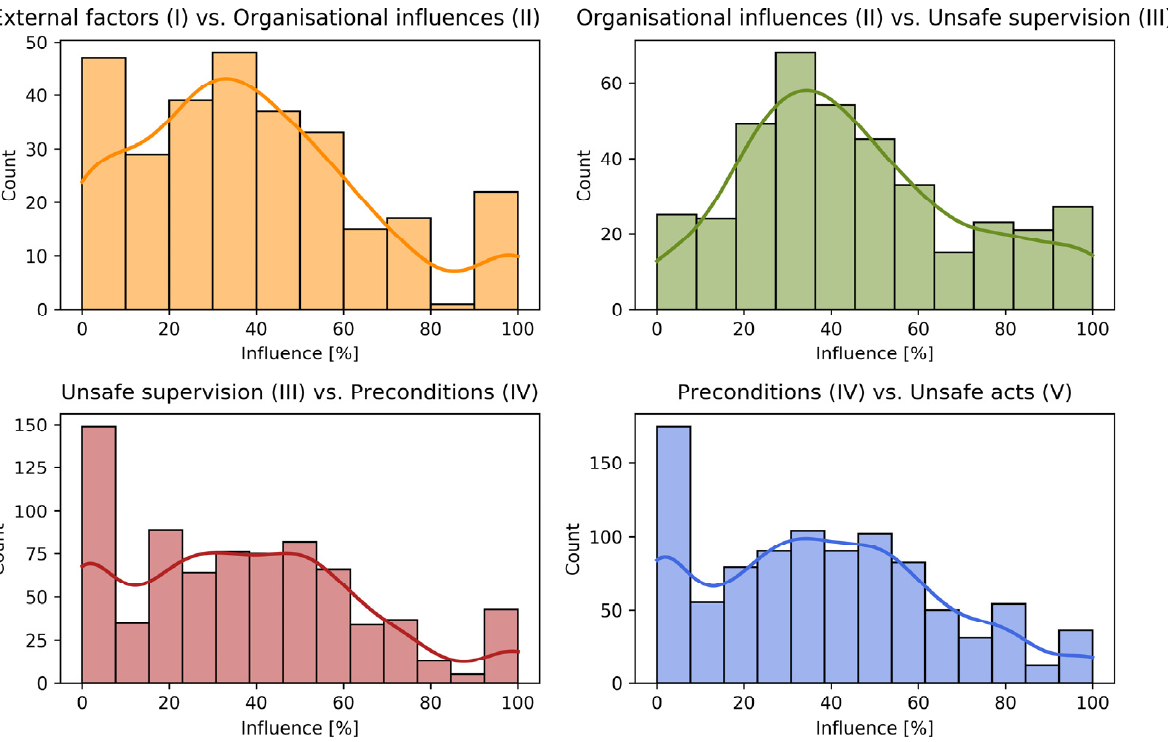
Figure 2. Histograms with kernel density estimation (KDE) of the responses collected on a particu- lar stage.